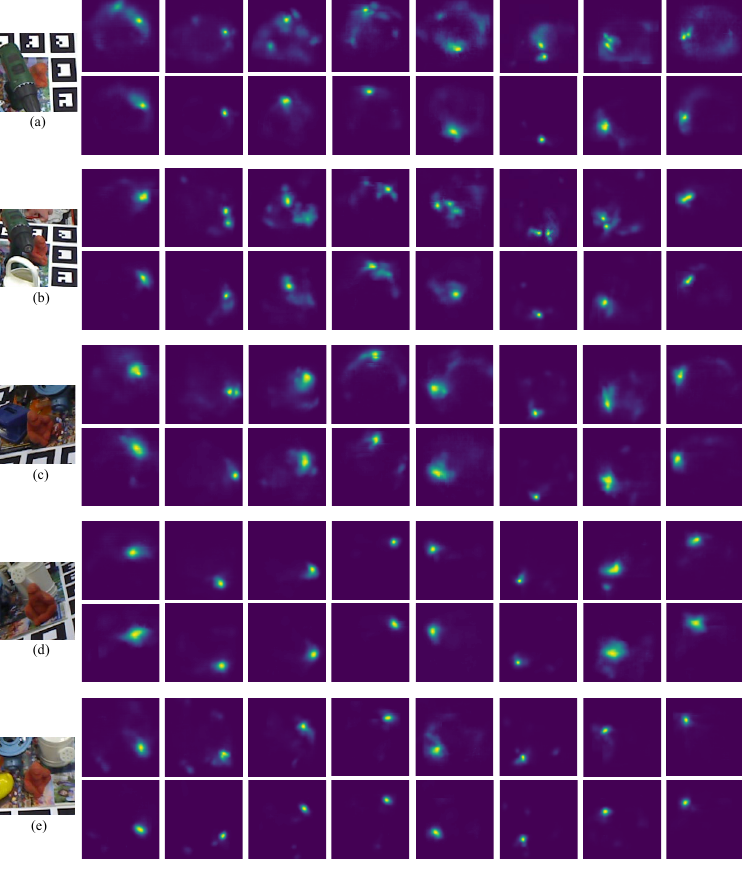
Figure 6. Predicted projection heatmaps from different RGB images of Occluded LineMOD dataset [6]. From ( a ) to ( e ), the region of interest of different test frames and its corresponding predicted heatmap channels with DeepHMap (up) and projection grouping module (down) are given,